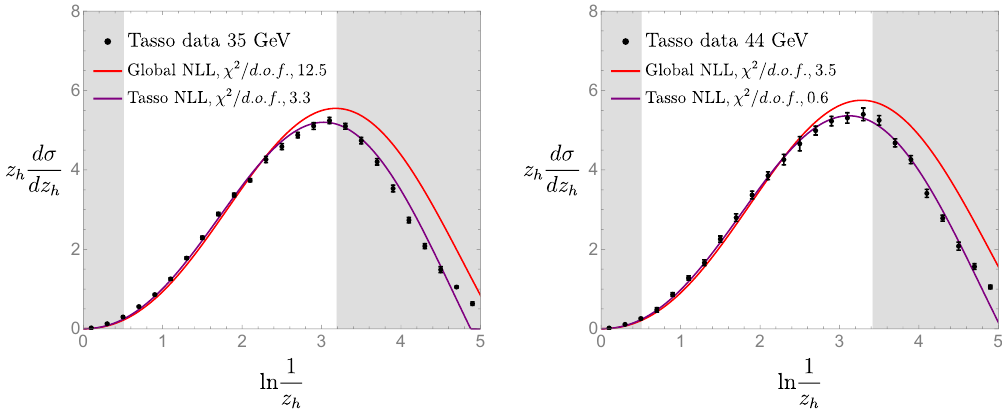
Figure 6 . The fragmentation spectrum for e + e − → h ± + X at center of mass energies Q = 35 and 44 GeV. The gray region is excluded from the χ 2 / d.o.f. determination based on hadron mass corrections or z (1) , and the quoted χ 2 / d.o.f. is the goodness-of-fit for that data set. I compare h ∼ O the global fit prediction to a fit to the lower Q data alone. The improved fit is achieved by only changing the scale at which splitting evolution is